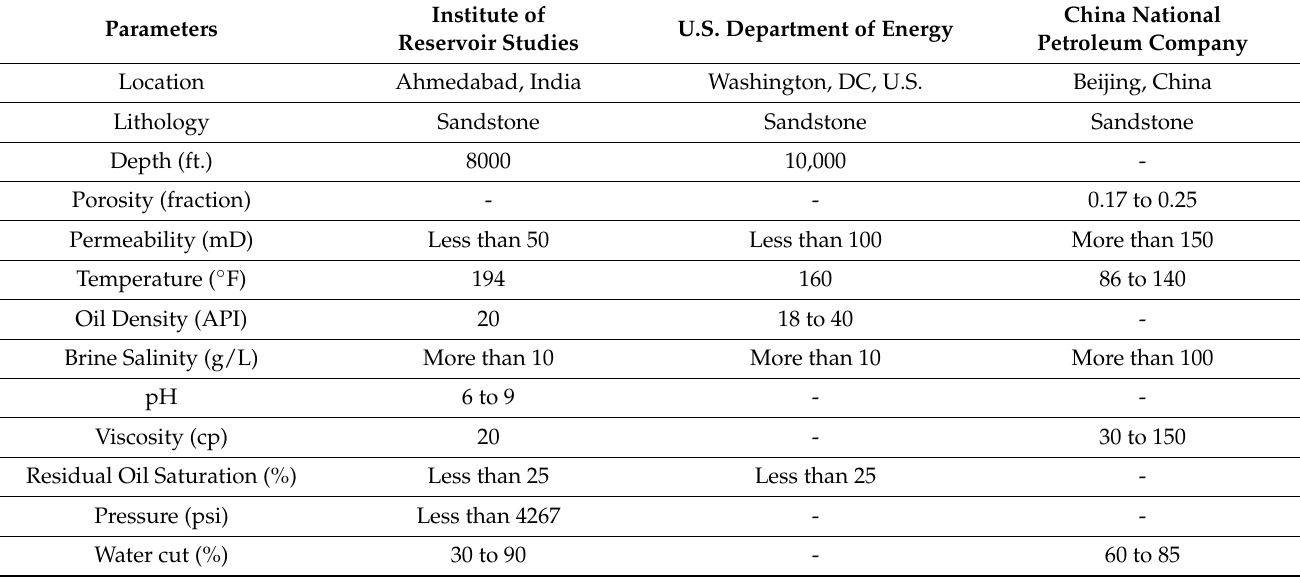
Table 4. Some vital screening criteria parameters of recent projects in powerful nations—India, U.S. and China.